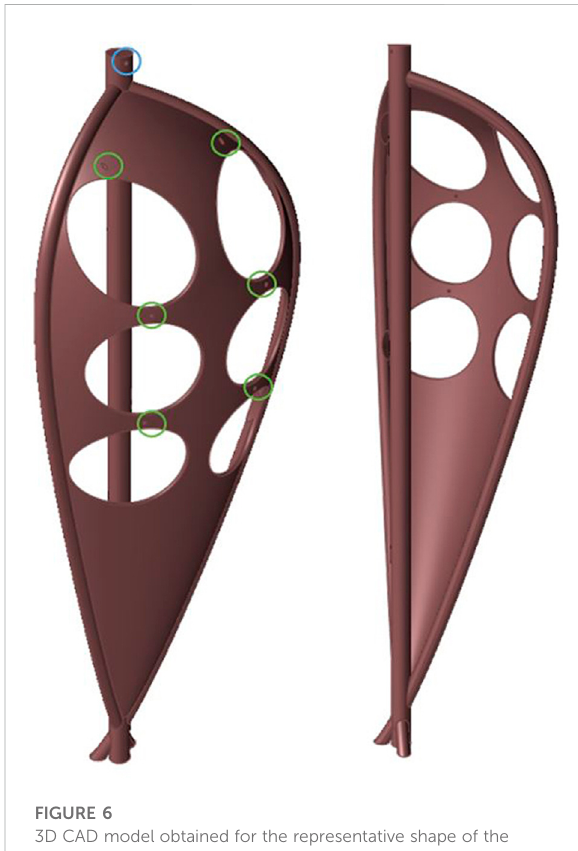
FIGURE 6 3D CAD model obtained for the representative shape of the 380-kV